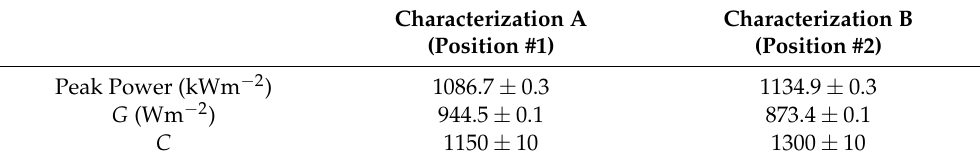
Table 2. Energy characterization results of the Fresnel lens for both positions, #1 and #2.